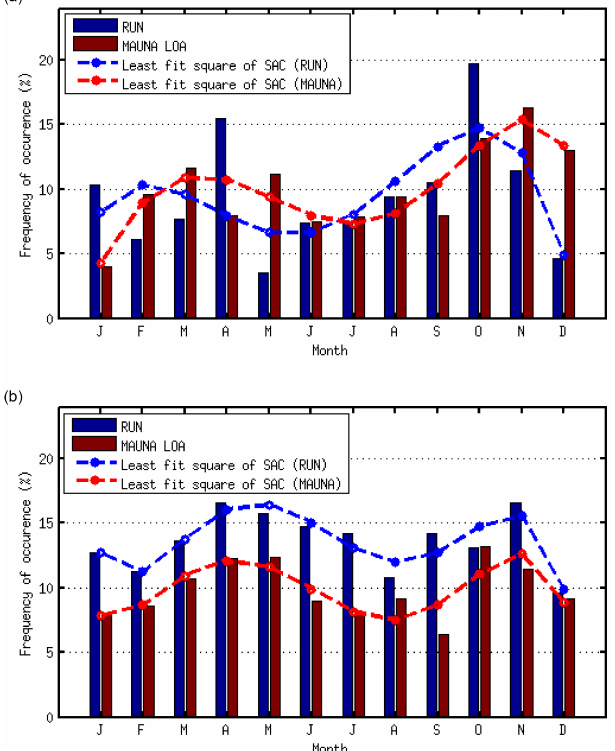
Figure 2. Frequency of occurrence of MIL events over Réunion (blue) and Mauna Loa (red) obtained from (a) lidar during the 1994–2009 period and (b) SABER observations during the 2002– 2015 period. The red and blue curves correspond to least squares fit of semi-annual oscillation for Mauna Loa and Réunion, respec-